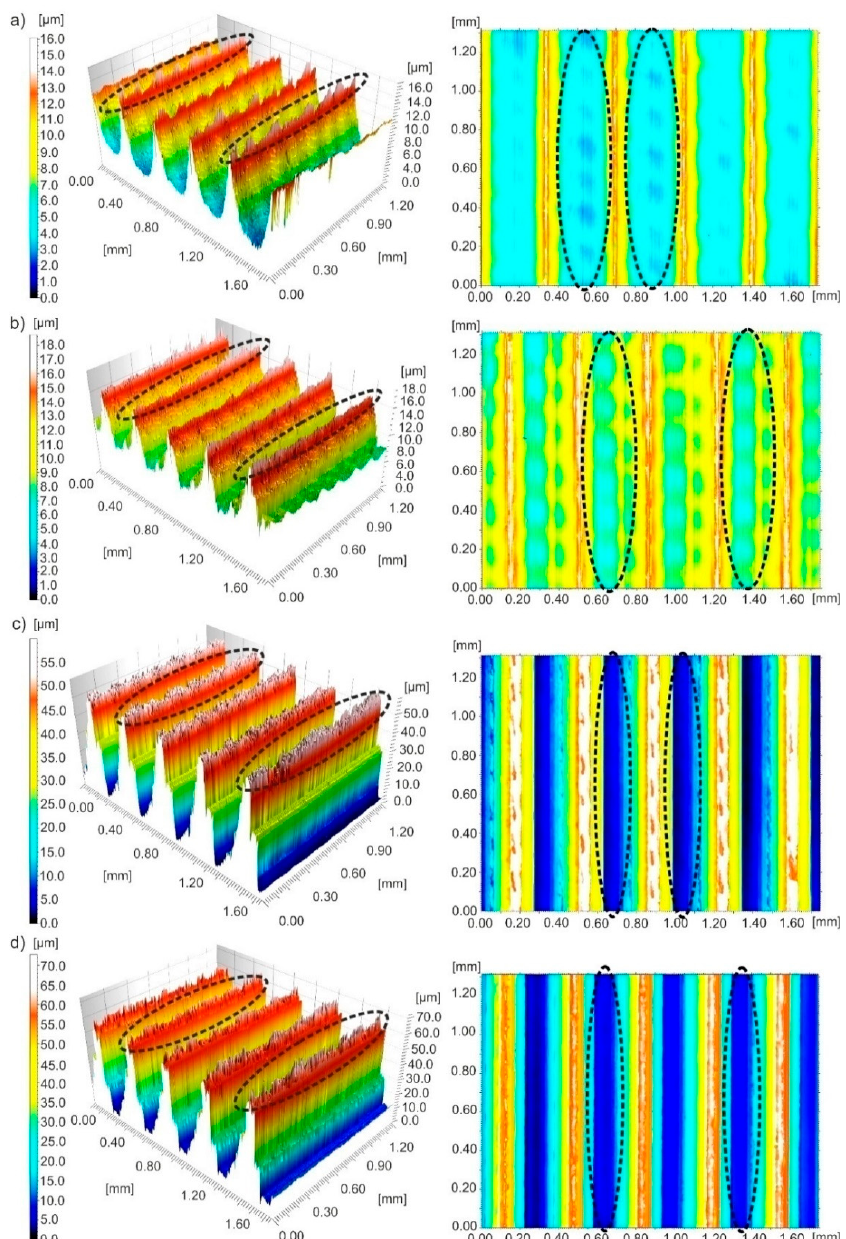
Figure 12. Three-dimensional images and contour maps of the surface machined with a speed of v c ~195 m/min and feed of f ~0.36 mm/rev obtained under processing conditions: ( a ) dry; ( b ) wet; ( c ) MQL; ( d ) MQL+EP. ( c ) MQL; ( d ) MQL +